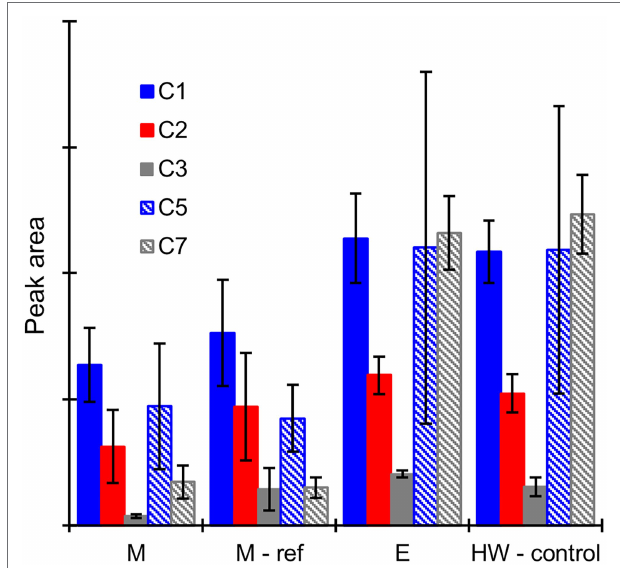
FIGURE 7 | Average GC–MS peak areas of degradation products C1, C2, C3, C5, and C7 in the heartwood extract after incubation with mycelium (M), autoclaved mycelium (M-ref), and extracellular culture fluid (E) derived from heartwood-supplemented R. placenta cultures, and in the control sample of extracellular culture fluid (HW-control) analysed without incubation with the heartwood extract. Error bars represent ±SD. No differences between M and M-ref and between E and HW-control were statistically significant ( p > 0.05 according to Student’s t -test). N =